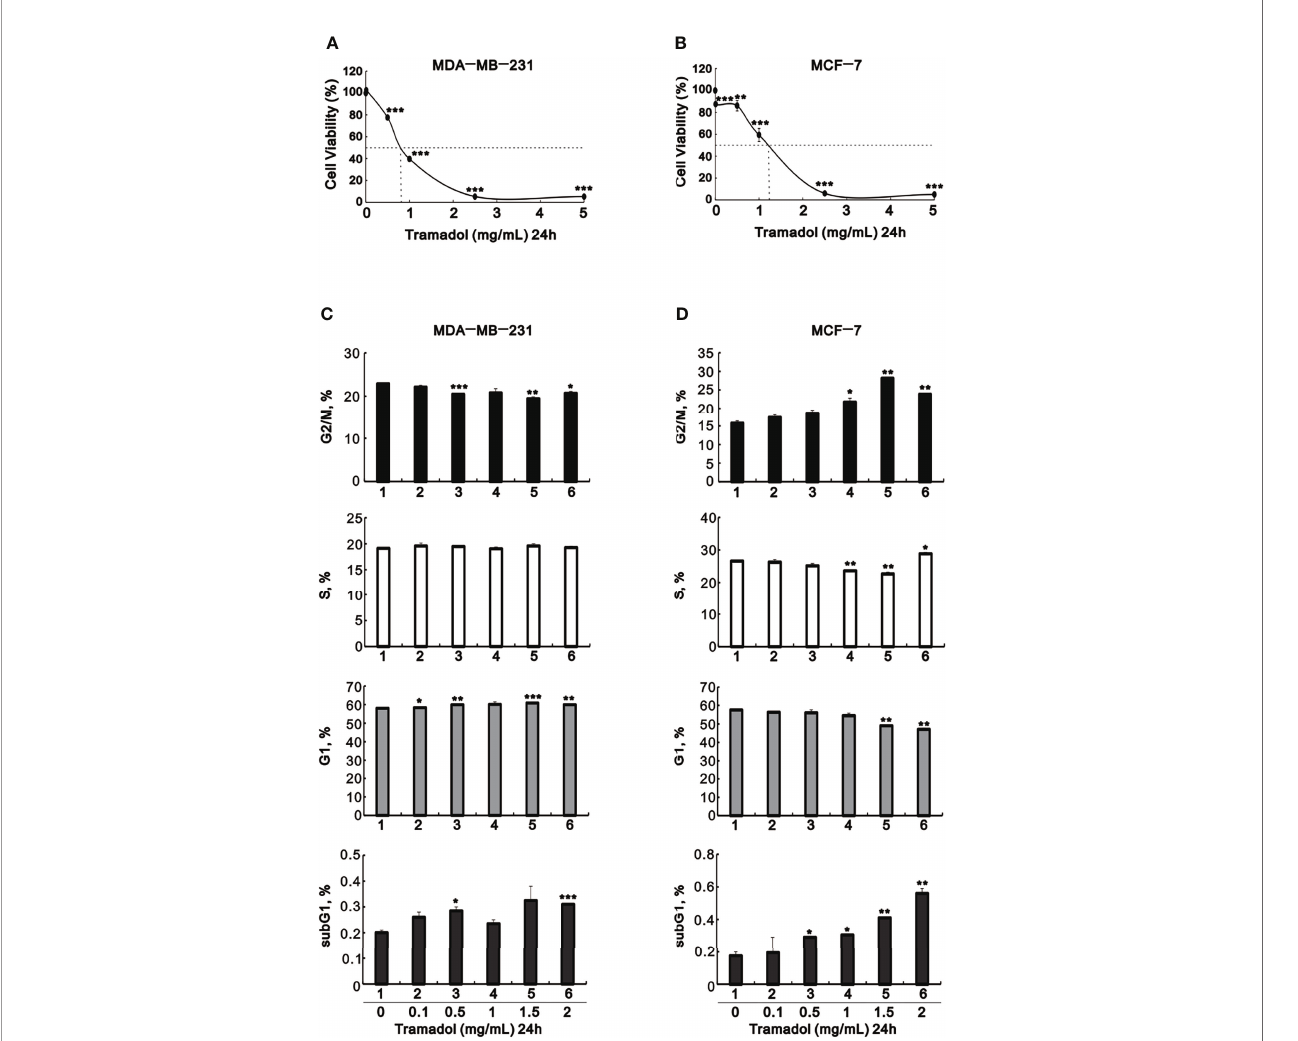
FIGURE 1 | The effects of tramadol on cell viability and the cell-cycle pro fi les of human breast cancer cells. (A – D) MDA-MB-231 and MCF-7 cells were treated with tramadol (0, 0.1, 0.5, 1.0, 2.5 and 5 mg/mL) for 24 h. (A, B) Cell viability was measured according to the MTT method. (C, D) For cell-cycle pro fi les, the cells were stained with propidium iodide (PI) and analyzed by fl ow cytometry. Bars depict the mean ± SD of three independent experiments. * p < 0.05, ** p < 0.01 and *** p < 0.001 (Student ’ s t